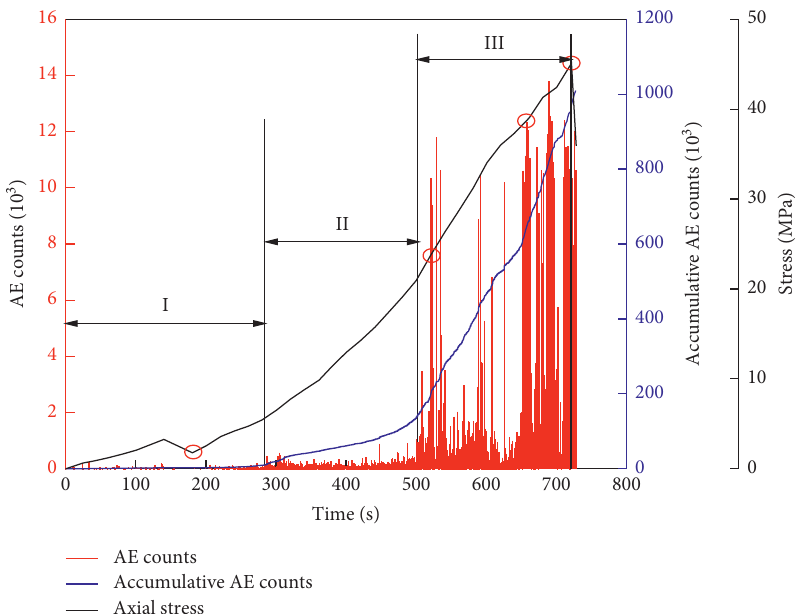
Figure 13: AE counts and accumulative AE counts of the jointed specimens with α � 60 ° .